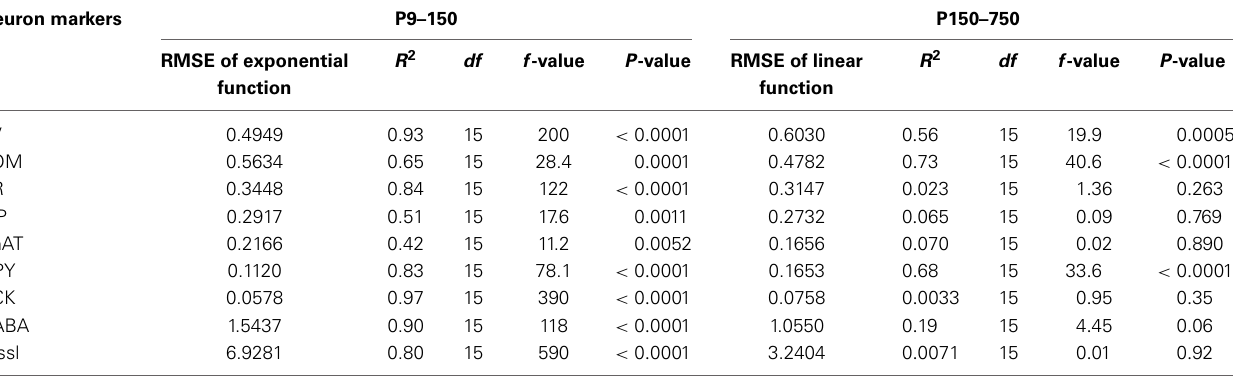
Table 2 | Goodness of fit values for all functions describing the trajectory of the neural markers examined during development (P9–150) and aging (P150–750).